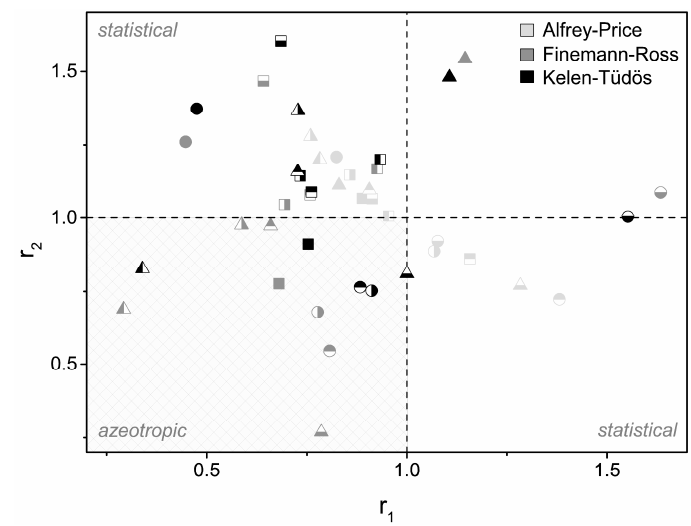
Figure 2. Copolymerization parameter ( r -parameter) plot for the following copolymers: MMA- co -EMA (filled squares), MMA- co -PrMA (half-filled squares top), MMA- co - n -ButMA (half-filled squares right), MMA- co - t -ButMA (half-filled squares bottom), MMA- co -CHMA (half-filled squares left), MMA- co -BzMA (filled circle), MMA- co -IBMA (half-filled circle top), EMA- co -MMA (half-filled squares right), EMA- co -PrMA (half-filled circle bottom), EMA- co - n -ButMA (half-filled triangle left), EMA- co - t -ButMA (filled triangle), EMA- co -CHMA (half-filled triangle top), EMA- co -BzMA (half-filled triangle right), and EMA- co -IBMA (half-filled triangle bottom). Different colors indicate the method according to which the parameters were determined as follows: light grey, Alfrey-Price; dark grey, Finemann-Ross; and black, Kelen-Tüdös. The individual squares highlight the copolymer types.